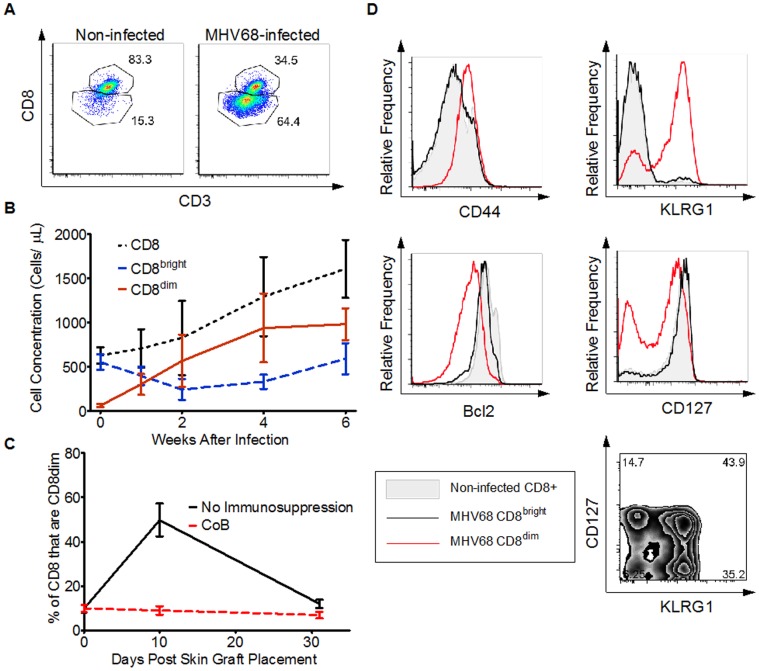
MHV68 results in the expansion of a unique T cell population, CD8dim.A) Flow cyotmetric plots showing CD8 versus CD3 staining after gating on lymphocytes by forward and side scatter followed by gating on CD3+/CD8+ cells. Flow cytometry was performed on peripheral blood samples drawn 6 weeks post-infection or in similarly aged non-infected animals. Each plot shows the combined results from equal numbers of cells from 5 animals. B) Longitudinal analysis in MHV68-infected animals of the absolute numbers of total CD8 (dotted black line), CD8bright (dashed blue line), and CD8dim (solid red line) T cells following infection. Data include 10 mice from 2 independent experiments except at 1 week where 5 mice from a single experiment are displayed. Error bars represent 1 standard deviation. C) Longitudinal analysis in non-infected B6 mice of the percentage of CD8 T cells that are CD8dim after placement of allogeneic skin grafts. The solid black line represents mice not receiving immunosuppressive therapy (n = 4). The dashed gray line shows mice receiving CTLA-4-Ig+anti-CD154 therapy (n = 6). Error bars show 1 standard deviation. D) Flow cytometric analysis at 6 weeks after infection comparing the relative expression of CD44, KLRG1, Bcl2, and CD127 with histograms between CD8 T cells from non-infected animals (gray filled area), CD8bright (solid black line) from MHV68-infected animals, and CD8dim (solid red line) from MHV68-infected animals. The plot in the bottom right shows the expression of CD127 versus KLRG1 for CD8dim in MHV68-infected animals. Each cell type for each plot shows the combination of 5 individual mice.